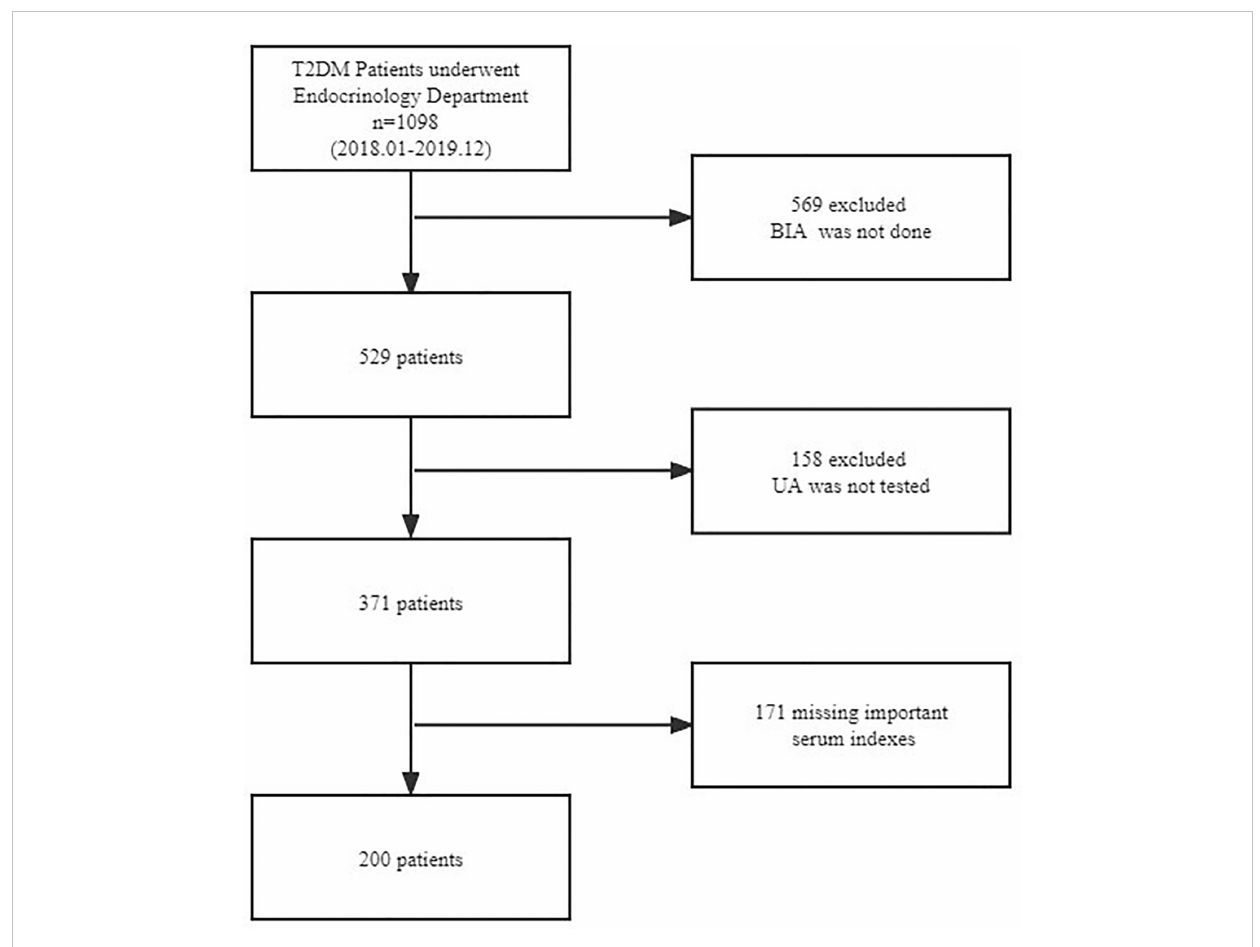
FIGURE 1 Flowchart of participant selection. T2DM, type 2 diabetes mellitus; BIA, bioelectrical impedance analysis; UA, uric